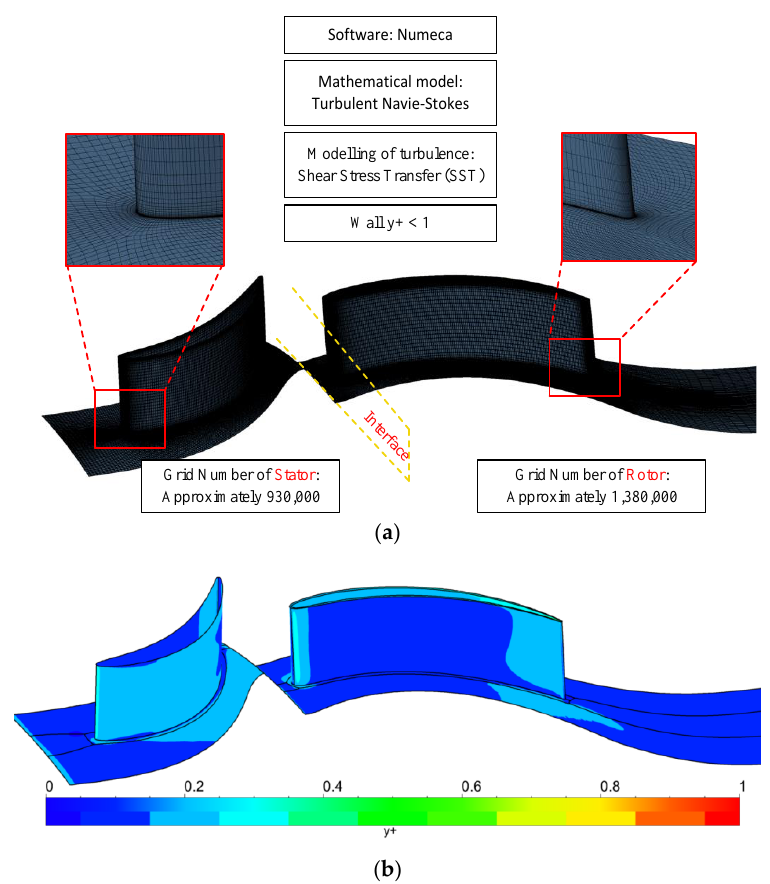
Figure 5. ( a )The grid of the tip turbine (conventional solidity). ( b )The contour of the implementation of y+.